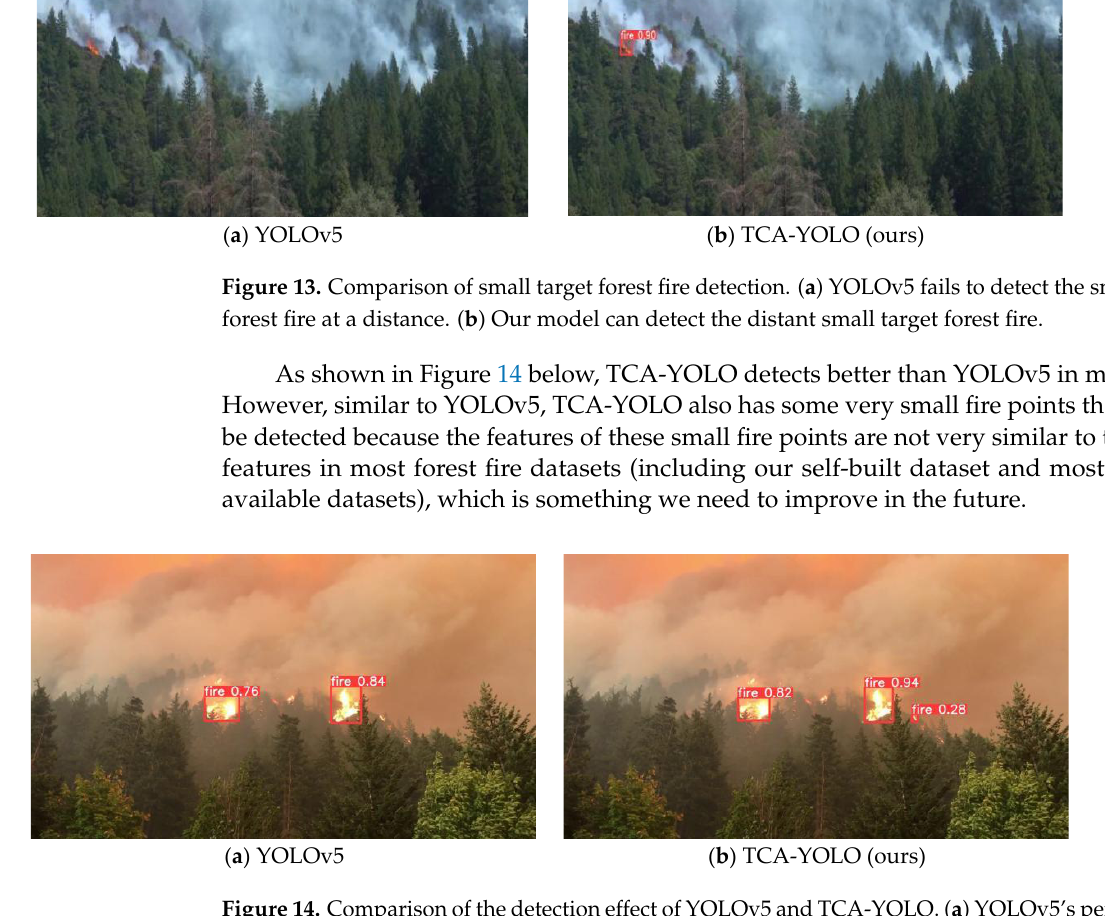
Figure 12. Comparison of whether forest fire targets will be missed.(a) YOLOv5 misses multiple fire targets. (b) Our model does not have missed detections.